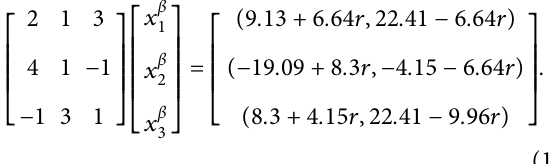
, 􏽥 U , 􏽥 U , 􏽥 U , and 􏽥 U 1 2 3 4